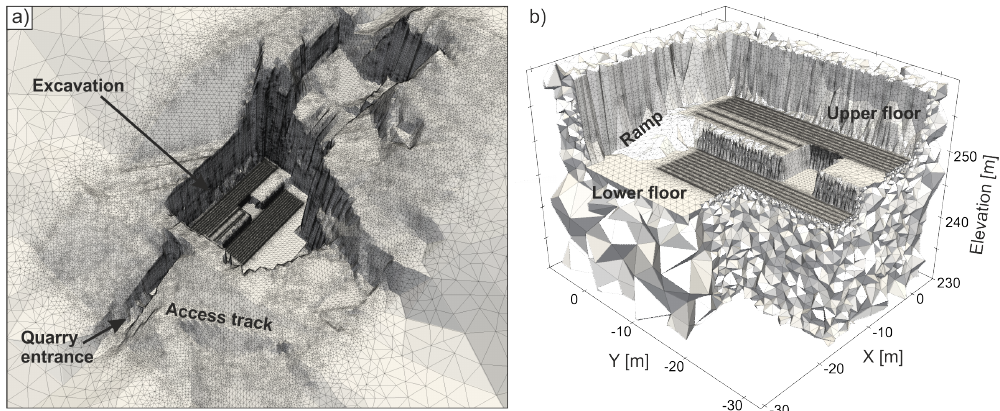
Figure 5. Discretization of the quarry domain. ( a ) View of the extended model showing the quarry surroundings, including the access track and the quarry entrance. The excavation has dimensions of 30 × 40 m. ( b ) Subset showing the discretization of within the imaging area, showing the mesh refinement around the electrode locations and the modelling of the quarry